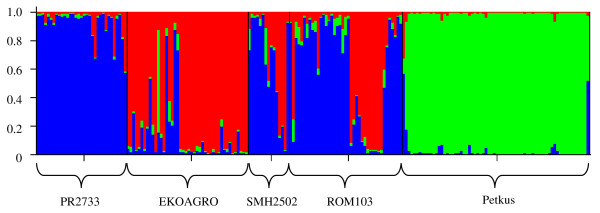
Population structure based on genotyping data of 37 SSR markers. Each genotype is represented by a thin vertical line, which is partitioned into k = 3 colored segments that represent the genotype's estimated membership fractions shown on the y-axis in k clusters. Genotypes were sorted according to populations along the x-axis and information on population origin is given.